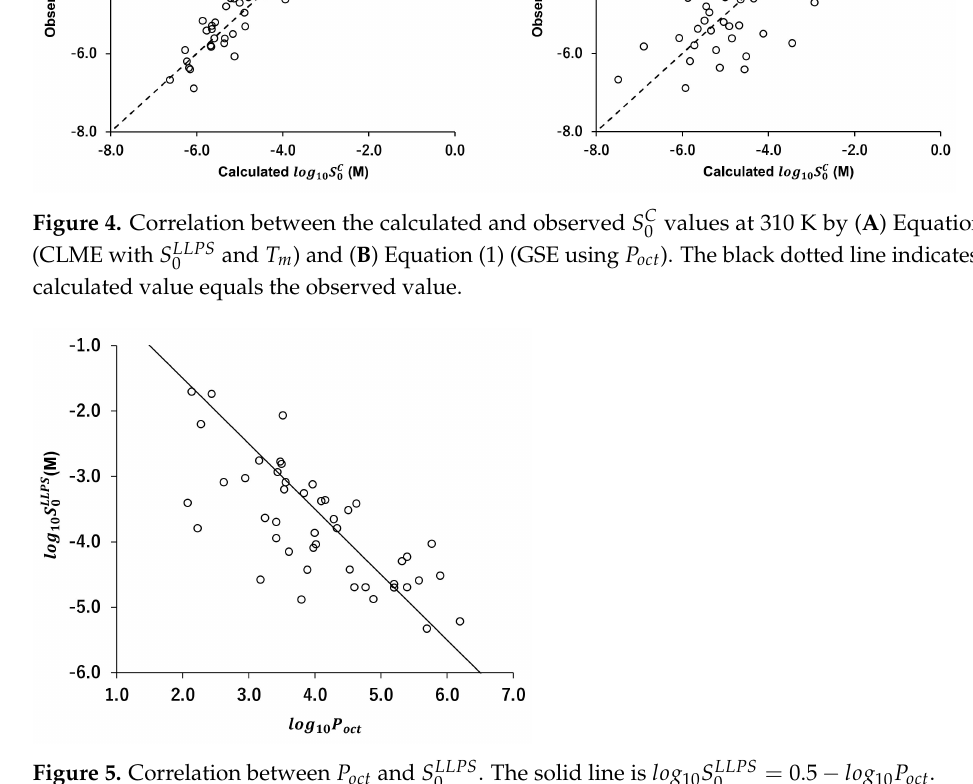
. The solid line is log 10 S LLPS 0